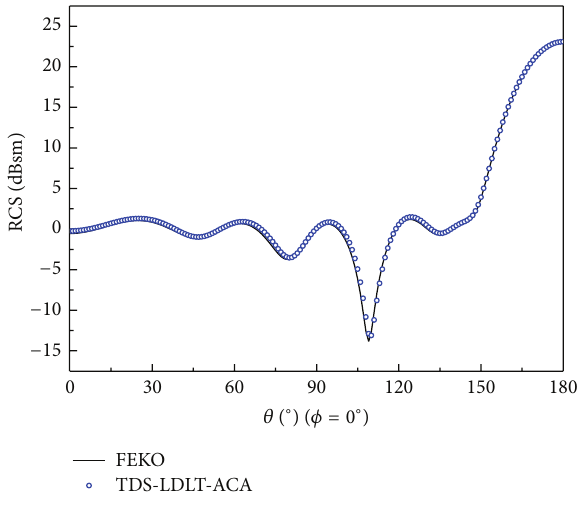
Figure 2: LHM coated PEC